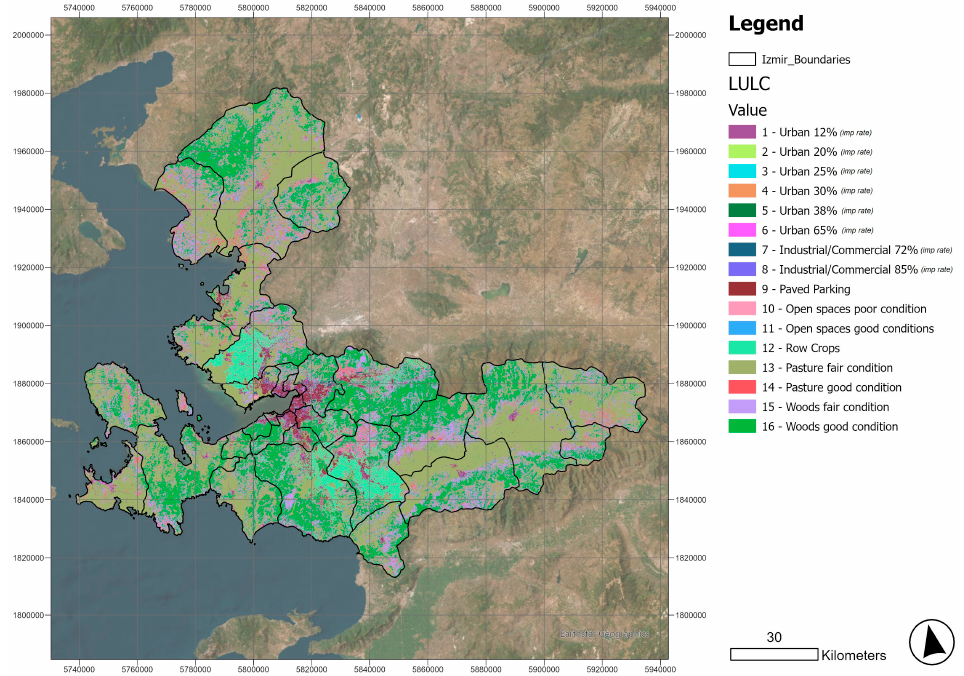
Figure 2. Raster map of land use land cover (LULC) with an indication of the imperviousness degree (imp_rate). Source: author’s elaboration based on EEA dataset: Imperviousness High-Resolution Layer 2018 (HRL); Tree Cover Density 2018 (TCD) and Urban Atlas 2018.